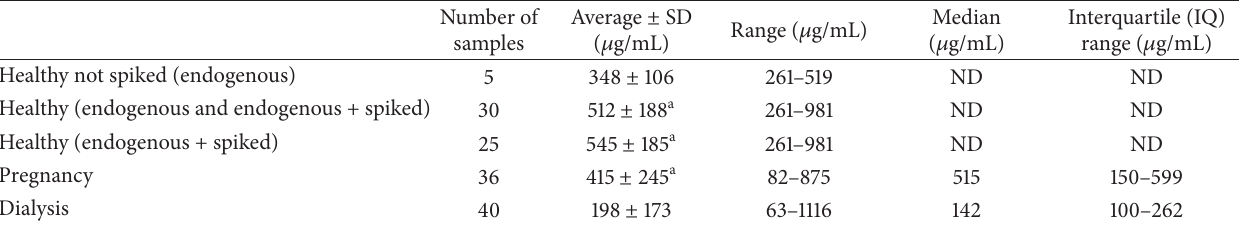
Table 1: Serum concentrations of vitamin D binding protein in healthy subjects, DBP-spiked samples from healthy subjects, pregnant women, and dialysis